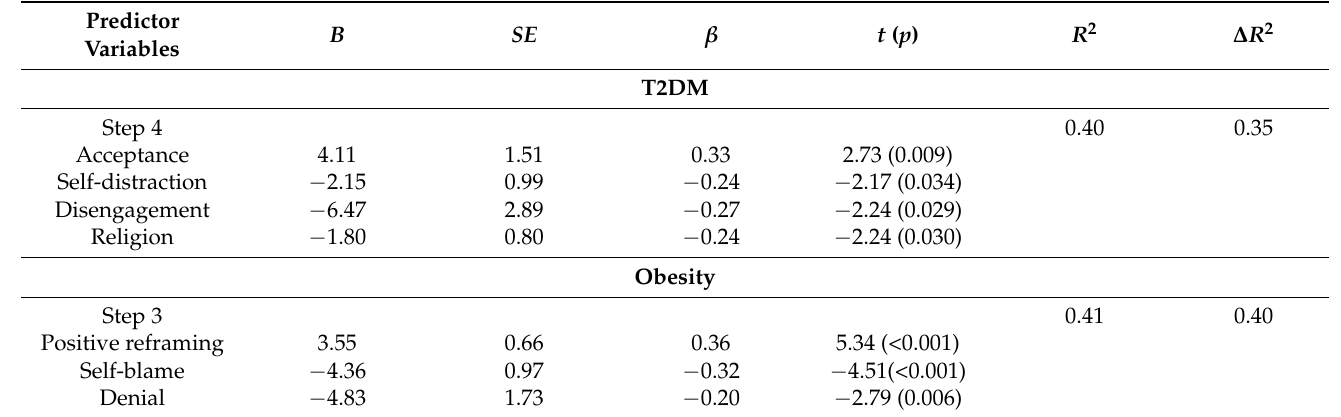
Table 7. Coping Strategies as Predictors of Mental Component Summary (SF-12).